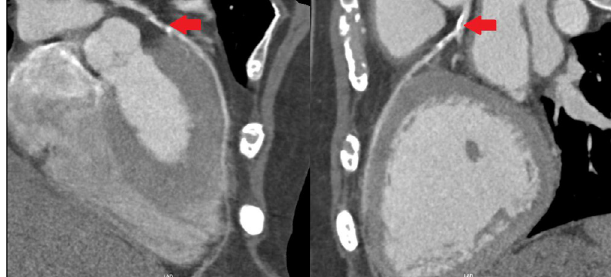
Fig. 2 – Anterior Descending Artery: Presents ostial and proximal lesion. Filled arrows indicate